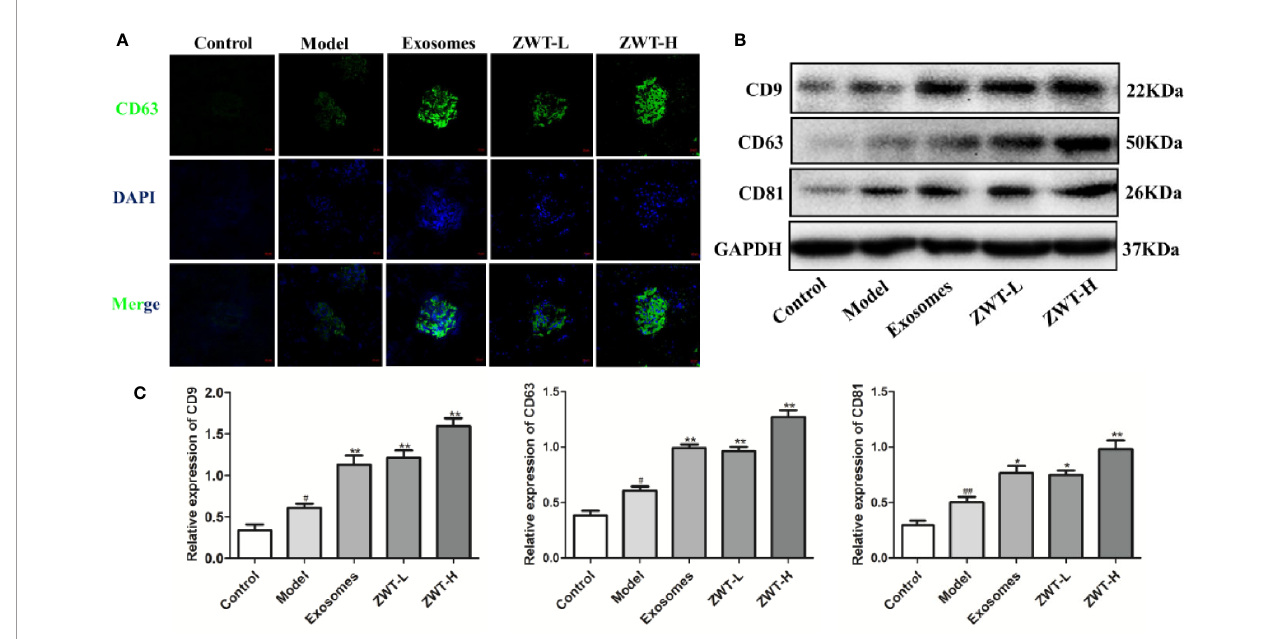
FIGURE 8 | Zhen-wu-tang (ZWT) was able to reinforce the secretion of exosomes in immunoglobulin A nephropathy (IgAN) rats. (A) CD63 expression in the glomerulus was evaluated by confocal imaging at ×200 magni fi cation. Scale bar: 20 m m. (B, C) Western blotting of CD9, CD63, and CD81 expressed in the glomerulus of IgAN rats. (n= 3).All values were presented as mean ± SD. # P < 0.05, ## P < 0.01, compared with control group; *P < 0.05, **P < 0.01, compared with LPS group.